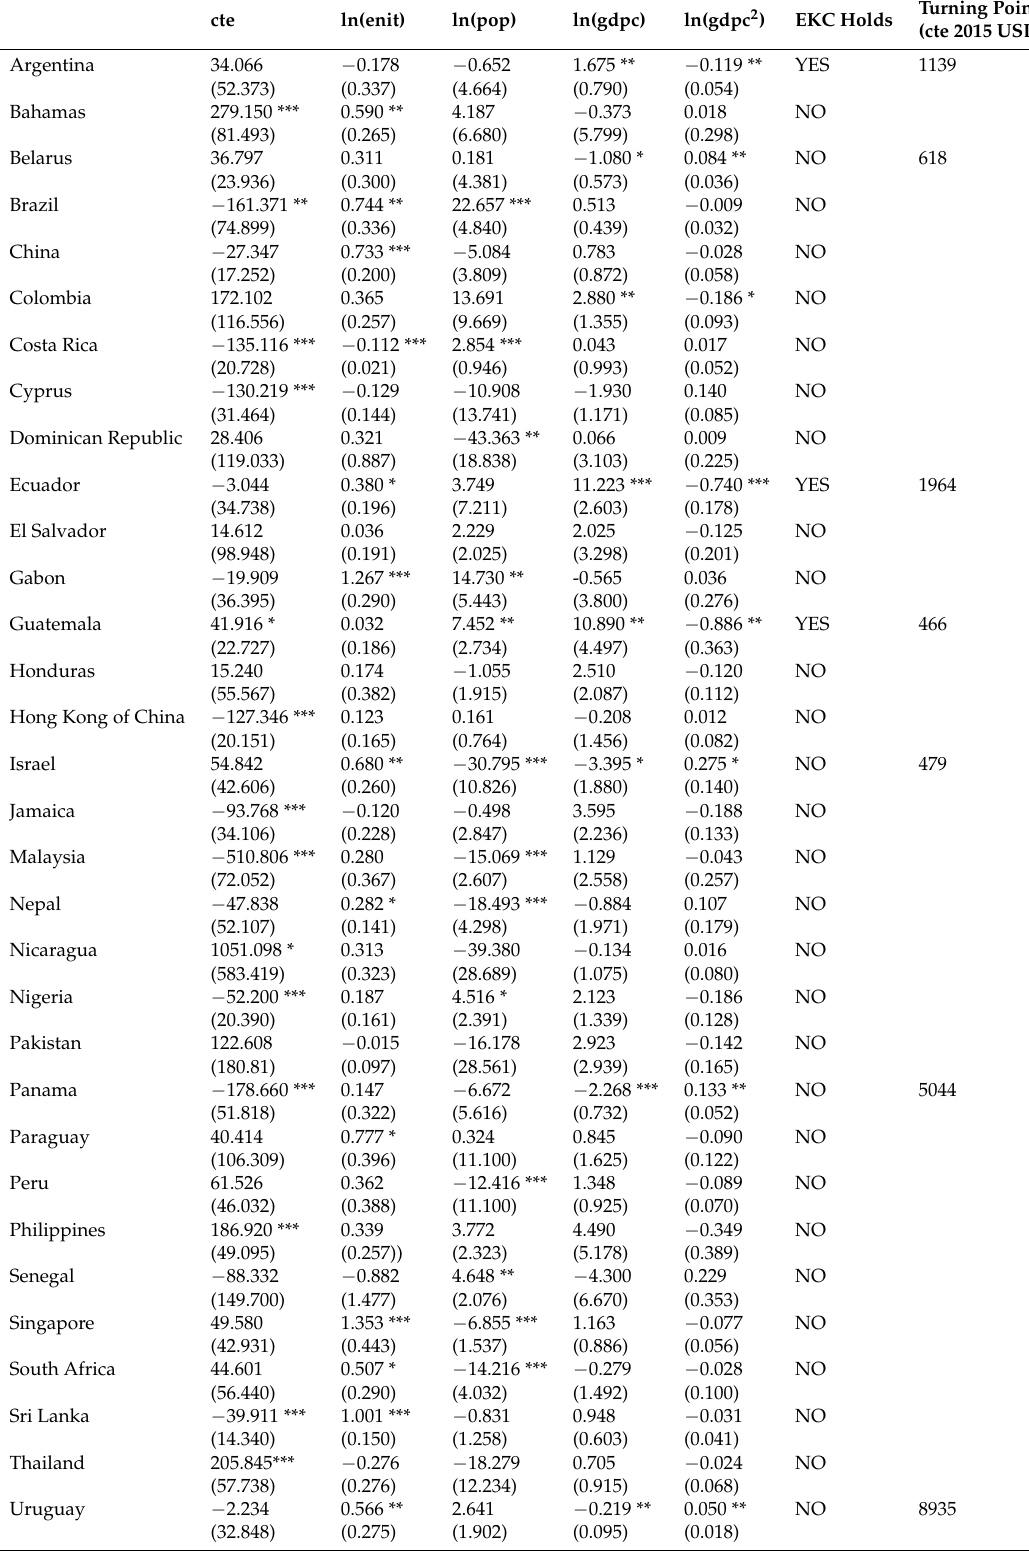
Table 5. Parametric estimates for the non-OECD countries. Fully parametric